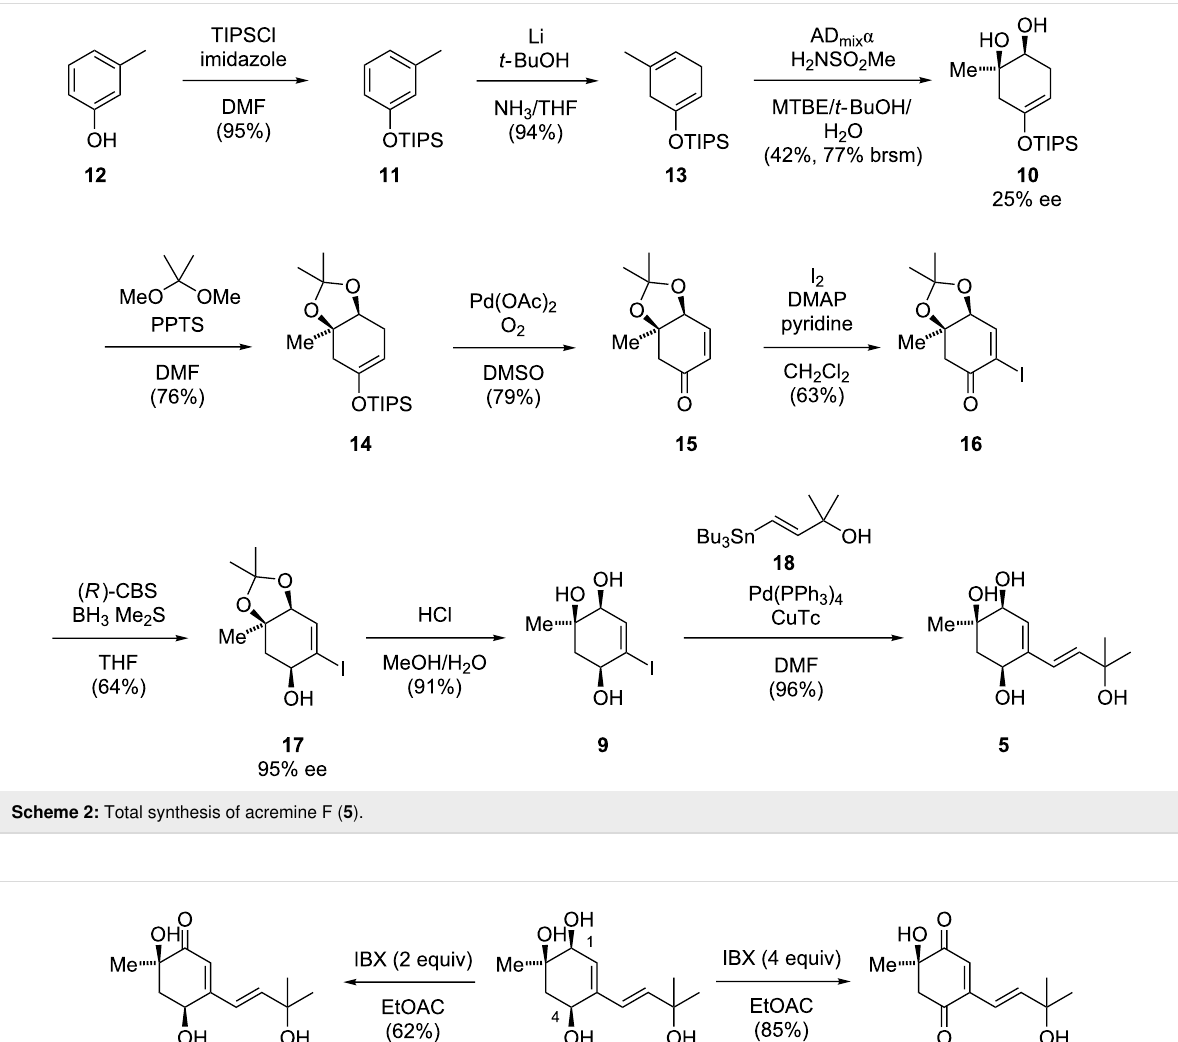
Scheme 3: Synthesis of acremines A and B through selective oxidation of acremine